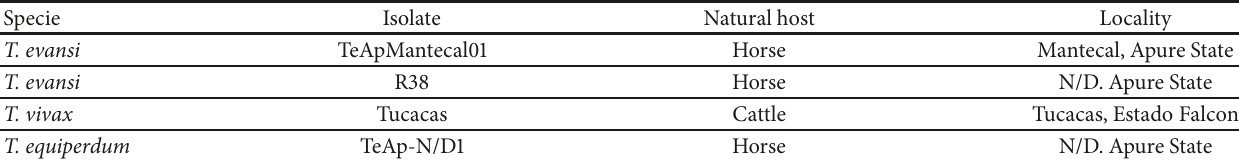
Table 1: Isolates of T. evansi, T. equiperdum , and T. vivax used in this study. Natural host and geographic localities. N/D: not determined.